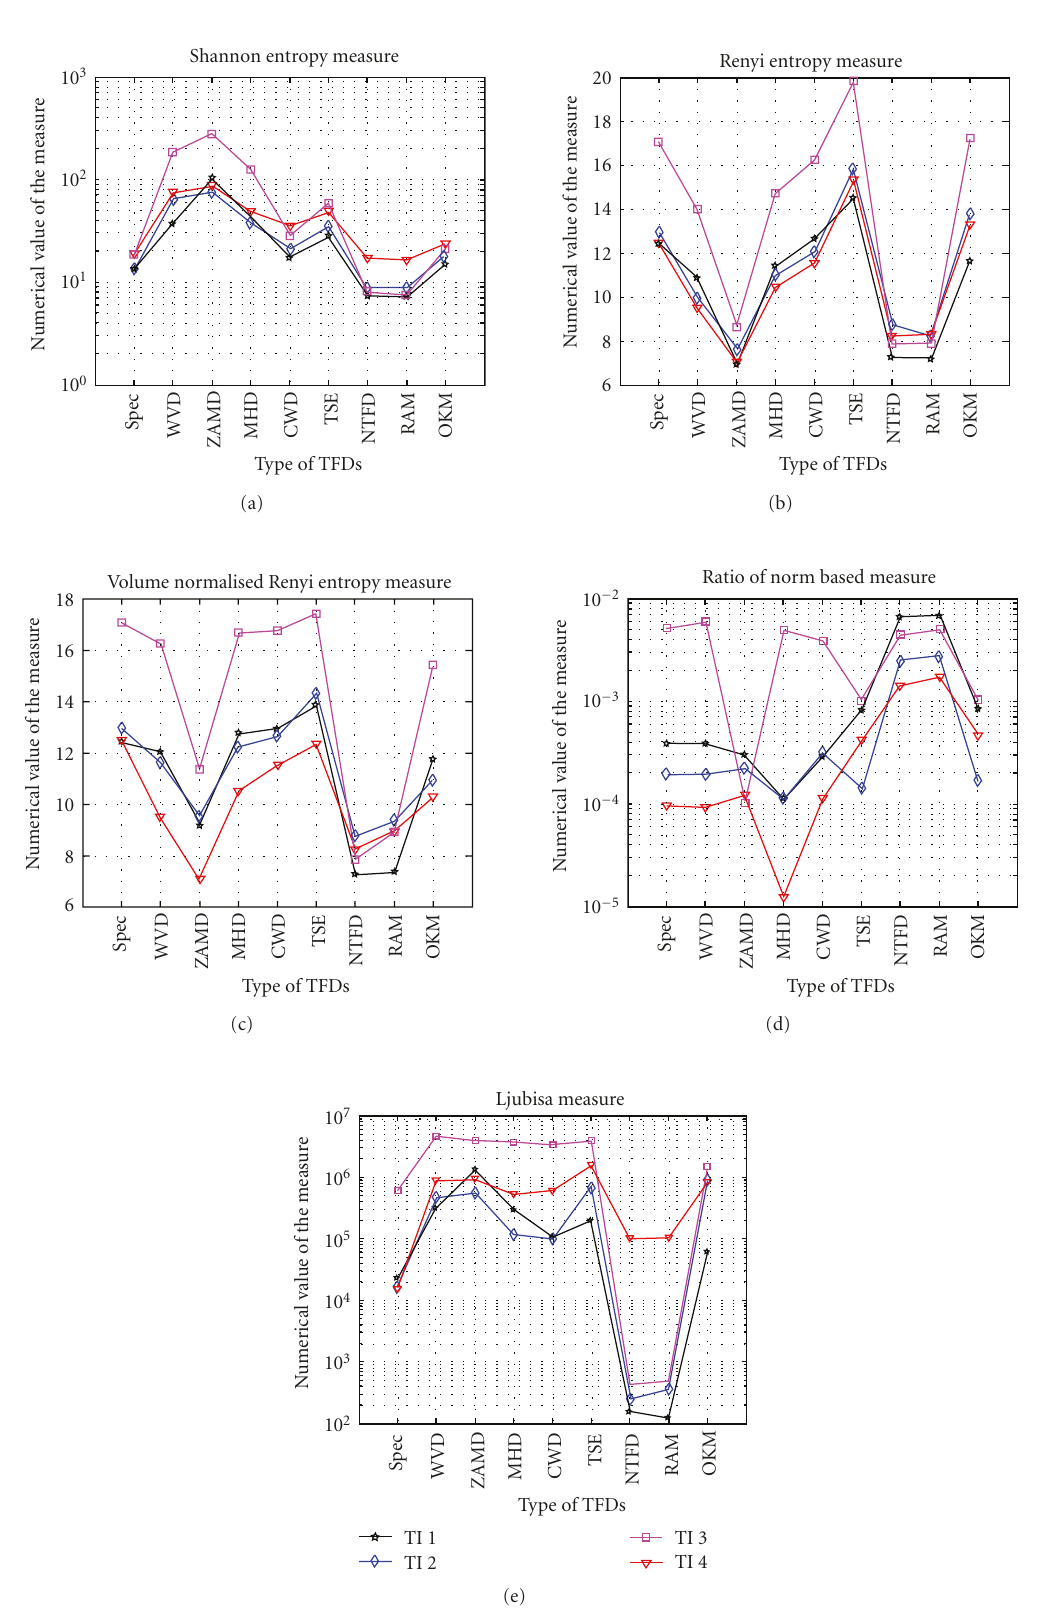
Figure 6: Comparison plots, numerical values of criterion versus method employed, for the test images 1–4, (a) The Shannon entropy measure, (b) R ´ enyi entropy measure, (c) Volume normalized R ´ enyi entropy measure, (d) Ratio of norm based measure, and (e) Ljubisa